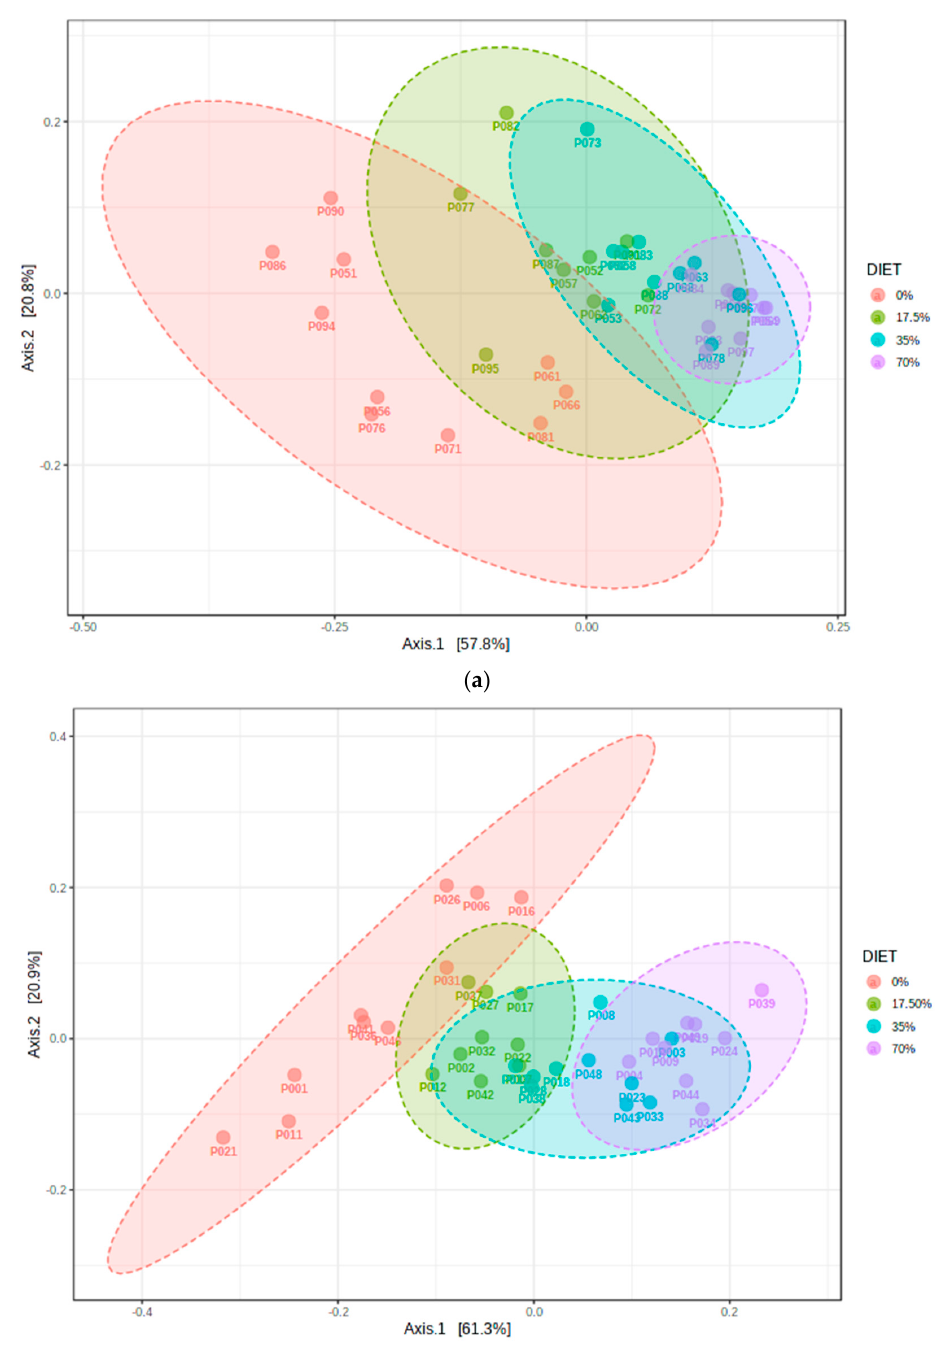
Figure 3. Phylogenetic Weighted UniFrac distances were used to explain β -diversity across diet groups. Differences between the samples were tested by the permutational multivariate analysis of variance (PERMANOVA): samples are colored and grouped by their corresponding diet group into ellipses representing 95% confidence intervals. ( a ) in the female cohort, pseudo- F -value = 12.845; p -value < 0.001. All diet groups were statistically different from one another; ( b ) in the male cohort, pseudo- F -value = 14.751; p -value < 0.001. All diet groups were statistically different from one an- other.